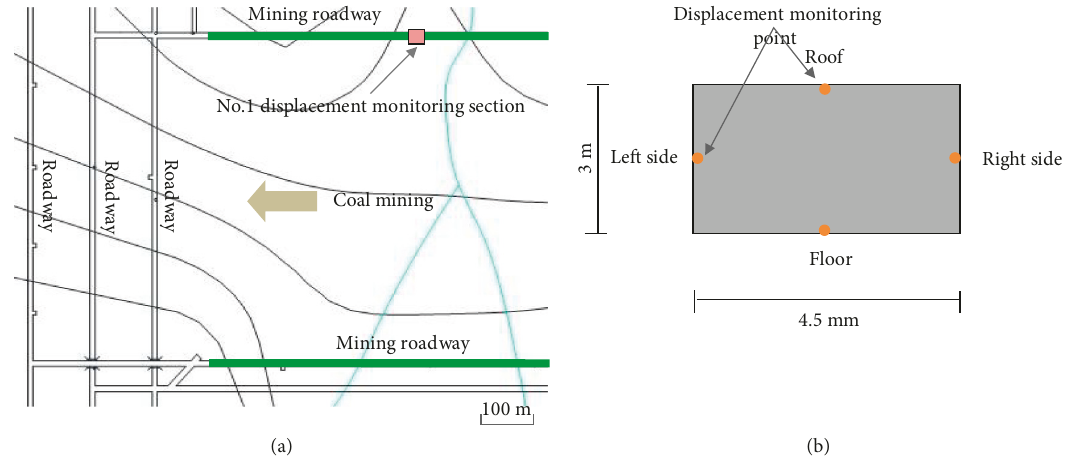
Figure 22: Design of roadway displacement monitoring; (a) Roadway plane position; (b) Layout of roadway displacement monitoring points.